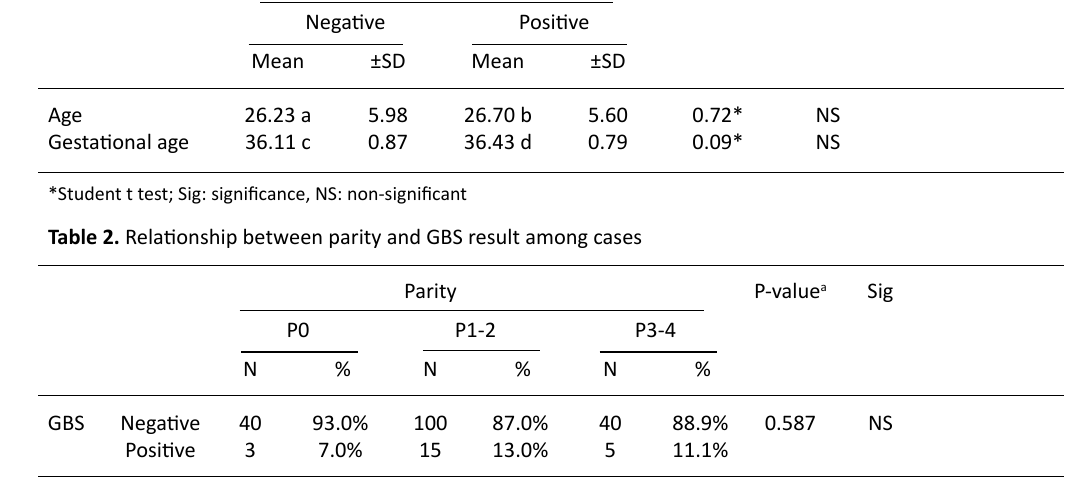
Table 1. Comparison between GBS positive and negative as regard age and gestational age GBS P-value e Sig Negative Positive